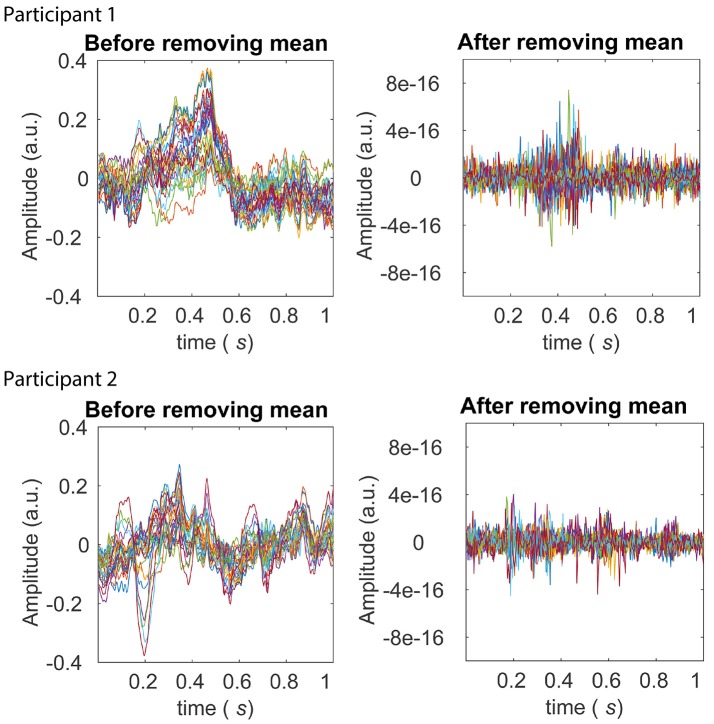
Averages across trials before and after the pre-processing stage of z-scoring across trials (within each experimental condition). The left panels in the top and bottom row display averages across trials after z-scoring across samples for Participants 1 and 2 from the BCI dataset, respectively. Averages from each of the 28 electrodes are shown in different colors. The P300 ERP is evident between around 0.2 and 0.5 seconds for both participants, in the left panels. The right panels in the top and bottom row display averages across trials for Participant 1 and 2 respectively, after the further pre-processing stage of z-scoring across trials. It is clear from scale of the right panels that across electrodes, any first-order (mean) sources of non-stationarity are eliminated.